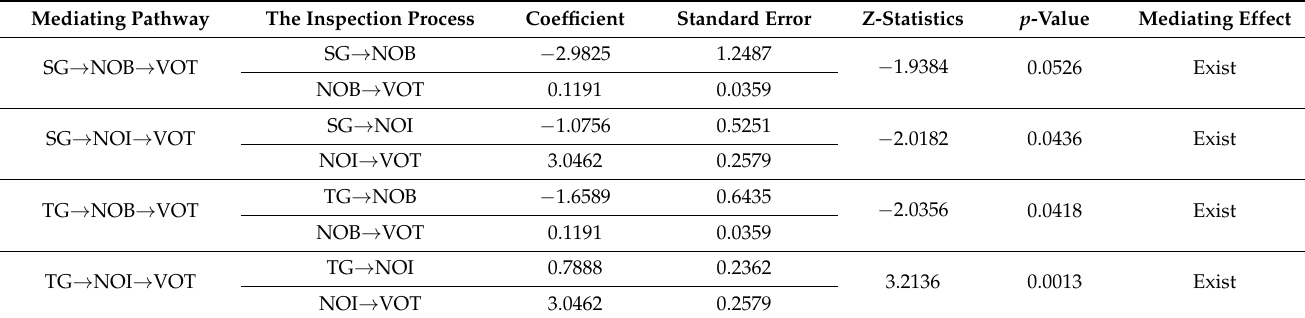
Table 10. Hypothesis validation of the mediating effect